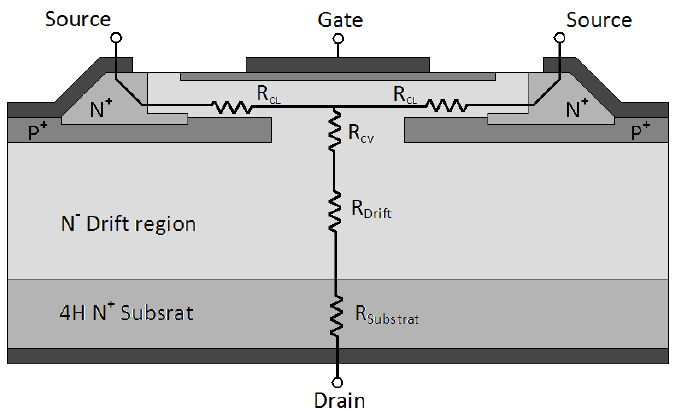
Figure 2. Two channels SiC-JFET resistance